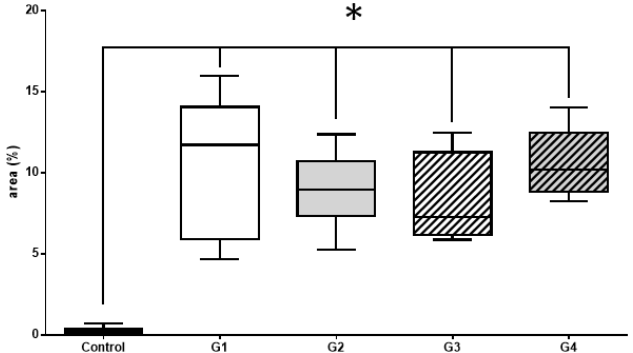
Figure 8. Immunohistochemistry—analysis of results immunomarked sections with OPN by ana- lyzing the Kruskal–Wallis statistical test with Dunn’s posttest. There was no significant statistical difference between the treated groups, but there was a statistically significant difference between the treated groups and the control group, which did not receive any type of treatment. Table 1. Histomorphometric analysis—Masson’s trichrome using the Mann–Whitney statistical test with a significance level of 5% ( p ≤ 0.05). ing the treatment modality performed, for the respective histomorphometric (Masson’s trichrome) and immunohistochemistry (VEGF and OPN) (Tables